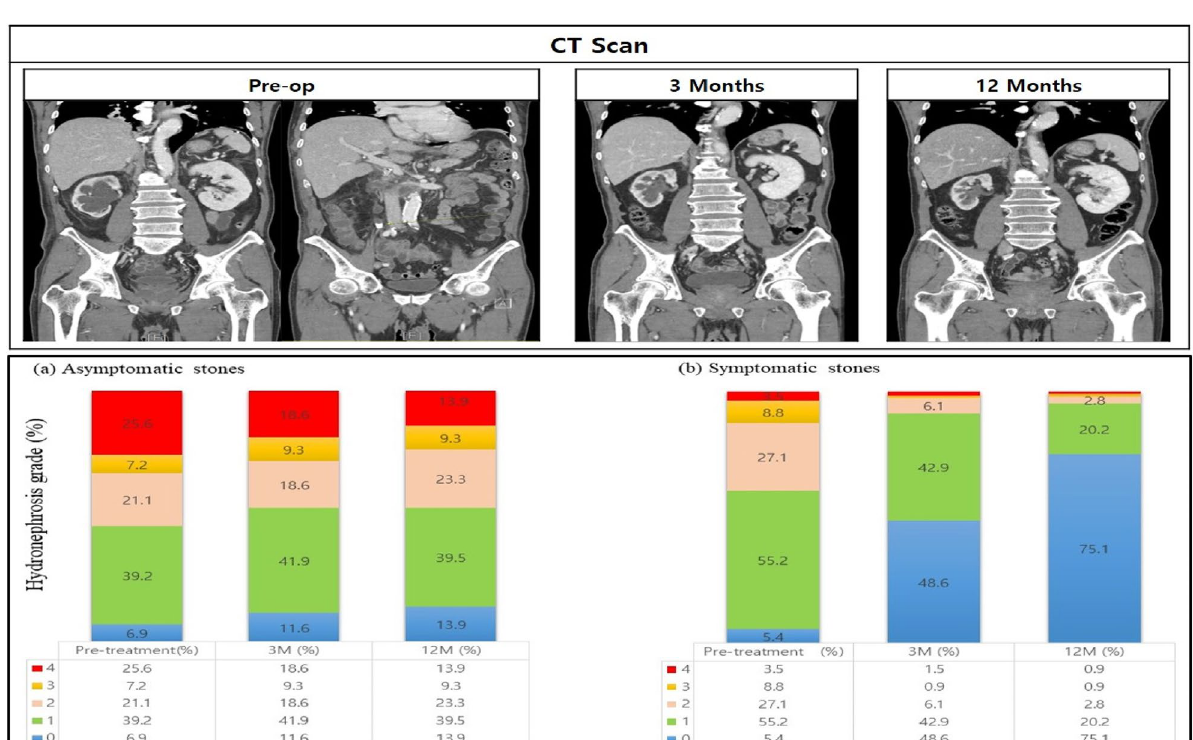
Figure 3. Changes in hydronephrosis grade estimated by serial computed tomography after stone